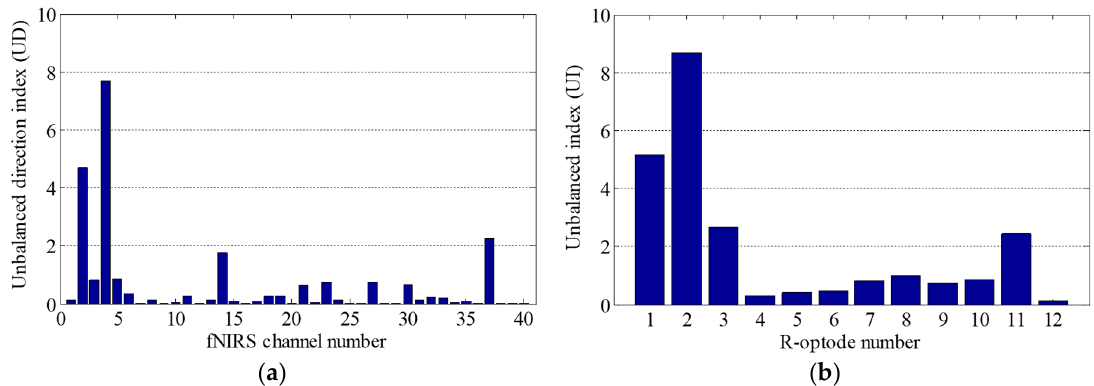
Figure 6. Flowchart of the proposed method.